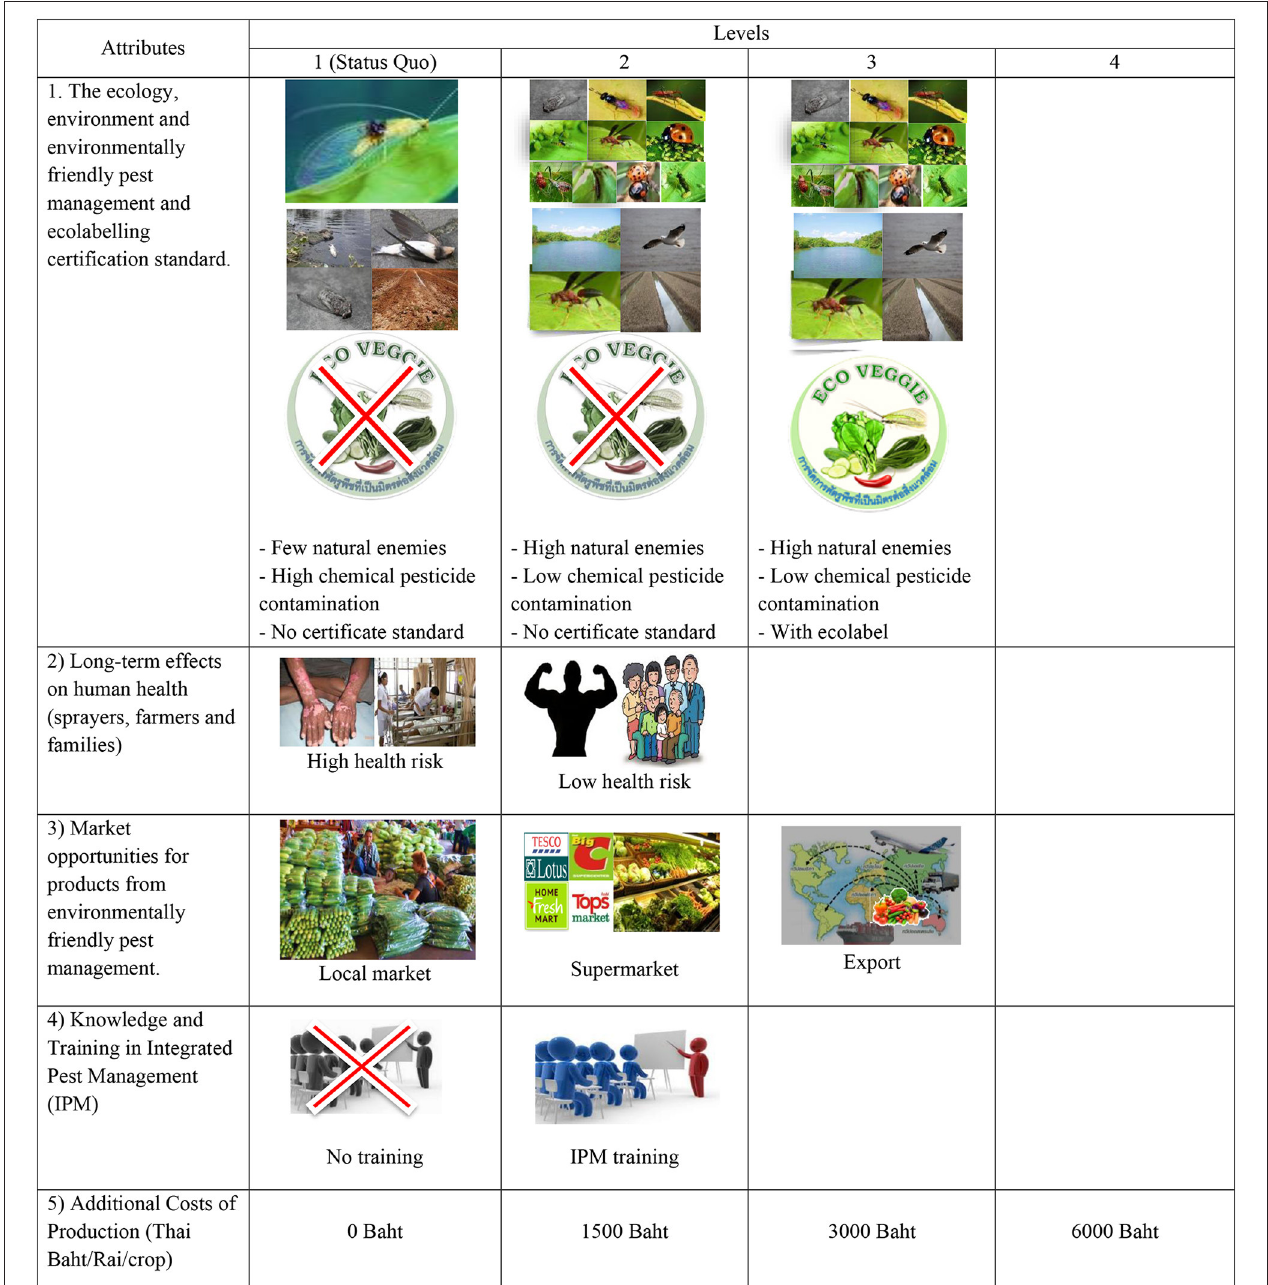
FIGURE 2 | Attributes and levels used in the choice experiment with pictures.